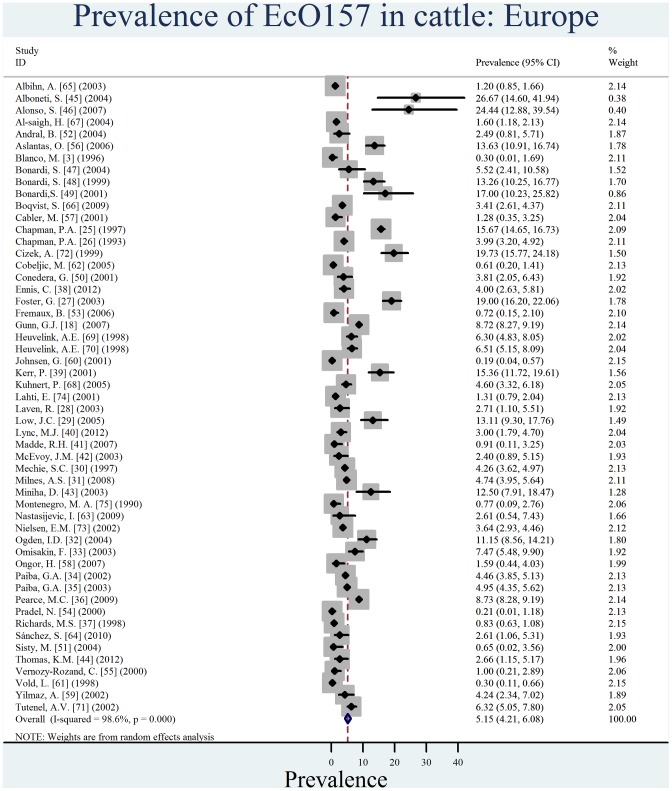
Forest plot of prevalence of E. coli O157 in cattle amongst studies conducted in Europe.